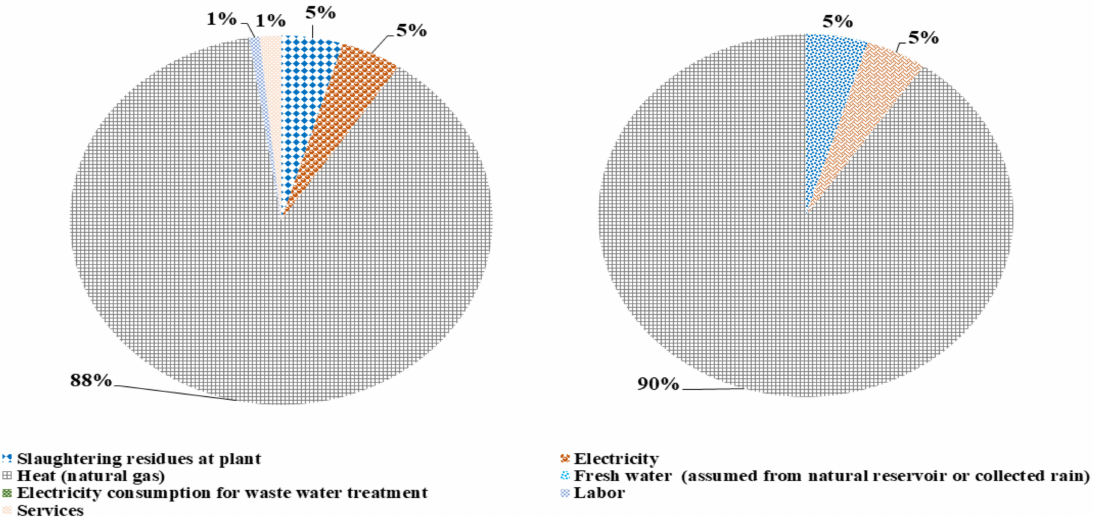
Figure 2. Emergy content, the contribution of different input flows for rendering I with and without